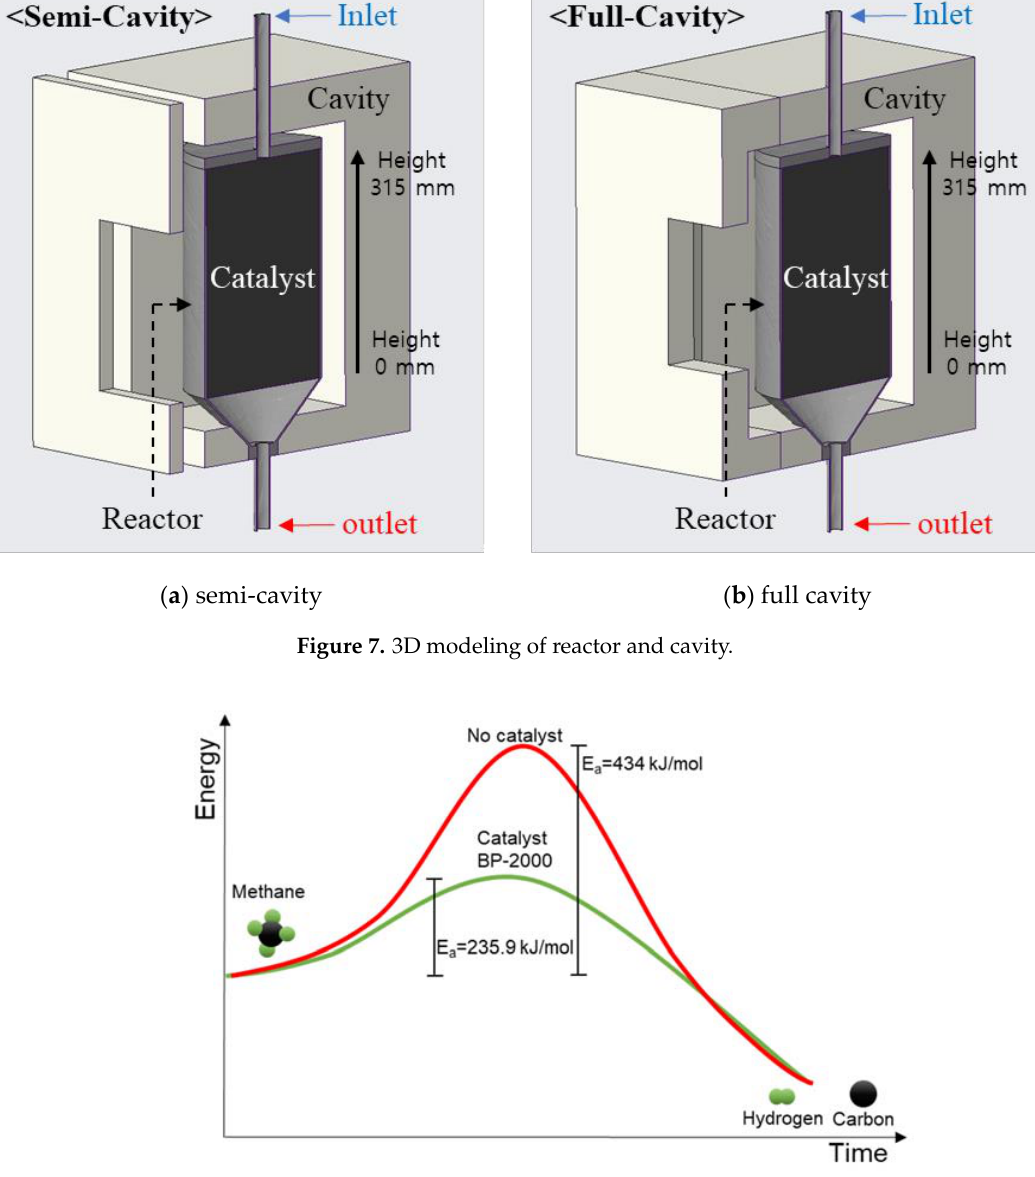
Figure 7. 3D modeling of reactor and cavity.